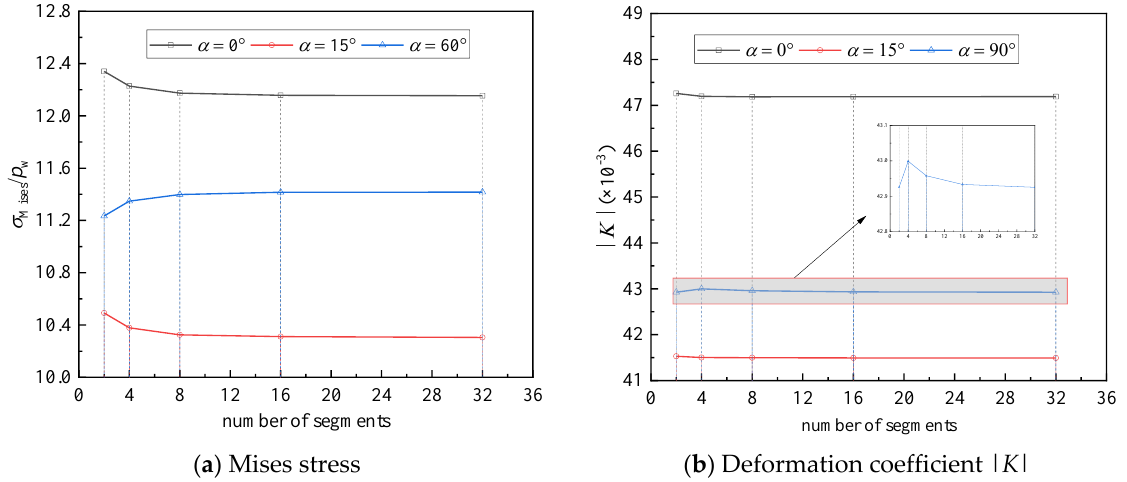
( b ) Deformation coefficient | K | Figure 13. The change trend of cylinder mechanical properties with the number of